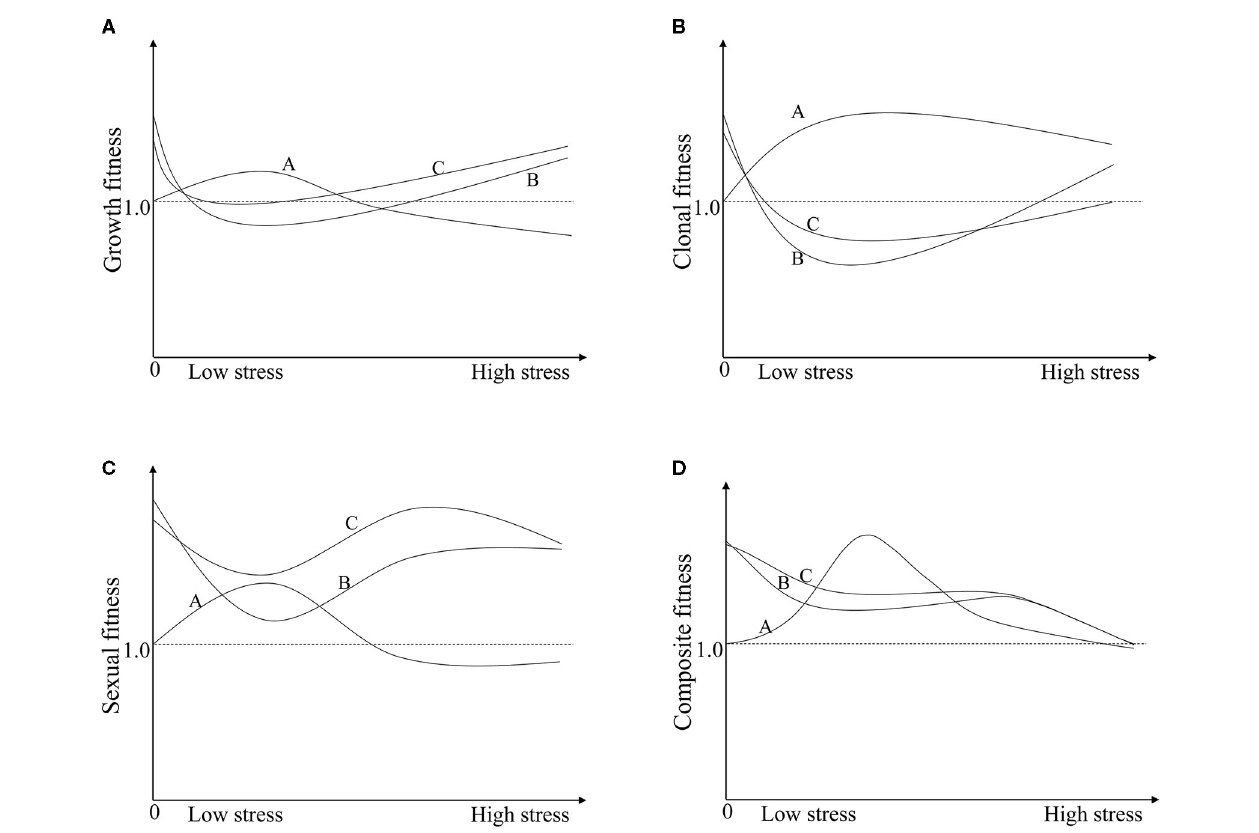
FIGURE 3 | The schematic diagram illustrates the variations in fitness between crop-wild hybrids (TN and TP) and the wild parent (W) along pressure gradients. Line A, W; Line B, TN; Line C, TP. (A) The growth fitness of W, TN, and TP; (B) The clonal fitness of W, TN, and TP; (C) The sexual fitness of W, TN, and TP; (D) The composite fitness of W, TN, and TP. In graph (D) : Line A, wild plants are able to equally- or overcompensate for insect pressure to a certain degree, then fitness increases under moderate insect pressure and decreases, eventually becoming negative, at a higher insect pressure. Line B, non-transgenic crop-wild hybrids under-compensate for insect pressure but display a hybrid vigour; then, the fitness decreases with the insect pressure. Line C, the fitness of transgenic crop-wild hybrids increases because of the transgene relative compared to that of their non-transgenic counterparts under certain pressure conditions. The cross points between lines A and B or C indicate that the effects of hybrid vigour or hybrid vigour and transgenes are fully offset by